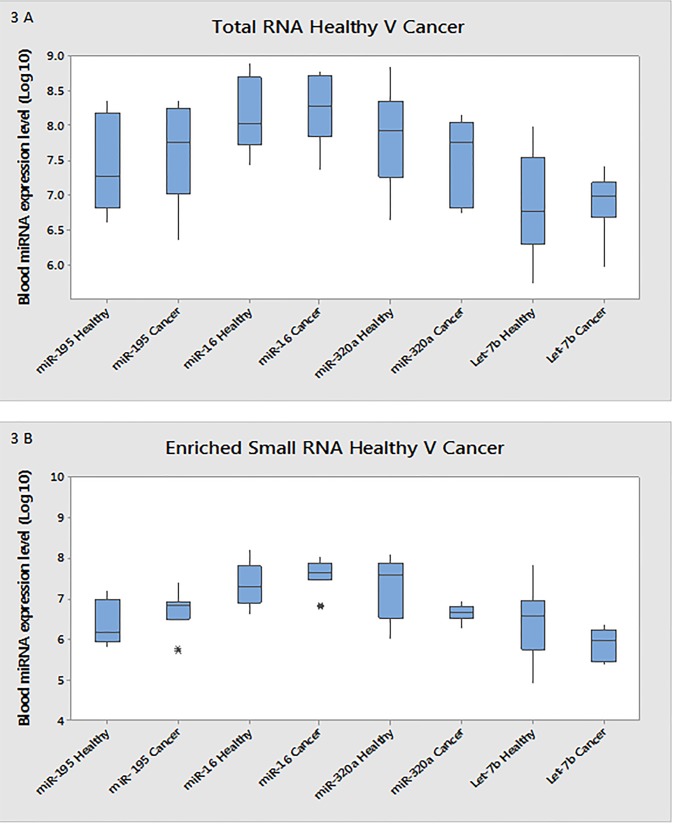
Differential analysis of miRNA isolated from total and enriched RNA from initial sample set.(A) Differential expression of miRNAs between healthy and cancer samples measured in Total RNA from the initial sample set measured using RT-qPCR A 2.3 fold decrease is observed (with a P value of 0.008), in miR-320a from Healthy (1.53E +08) to Cancer (6.63E +07) state. Log 10 box-plots indicating changes in expression of miR-195, miR-16 and Let-7b from healthy to cancer state measured in total RNA using RT-qPCR. (B) Differential expression of miRNAs between healthy and cancer samples measured in enriched small RNA from the initial sample set measured using RT-qPCR. A 5.45 fold decrease is observed (with a P value of 0.0001), in miR-320a from Healthy (4.24E +07) to Cancer (7.78E +06) state. Log 10 box-plots indicating changes in expression of miR-195, miR-16 and Let-7b from healthy to cancer state measured in total RNA using RT-qPCR. *Indicates an outlying value.